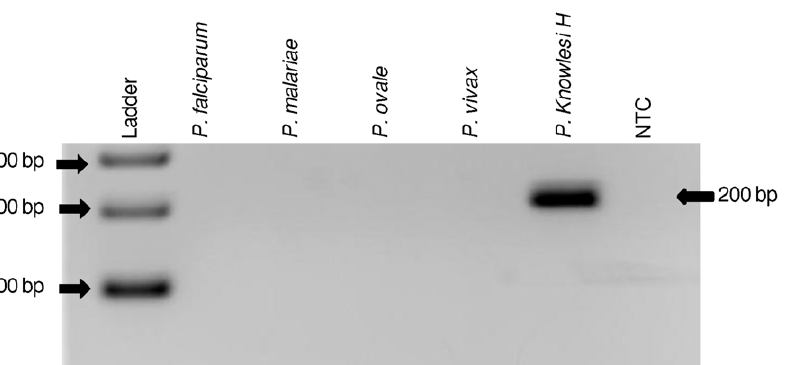
Figure 2. Primer Pkr140-5 tested with the 4 human-infecting malaria species. To test the specificity of the novel primers, DNA from the four additional human-infecting Plasmodium parasites were tested. P. knowlesi (H strain) was used as a positive control (expected size=200bp). A no template control (NTC) was also included. doi:10.1371/journal.pone.0031848.g002 primer set were able to detect up to 1 parasite of P. knowlesi / m L of blood with the novel primer set showing better resolution than the previously published primer set (Figure 5).